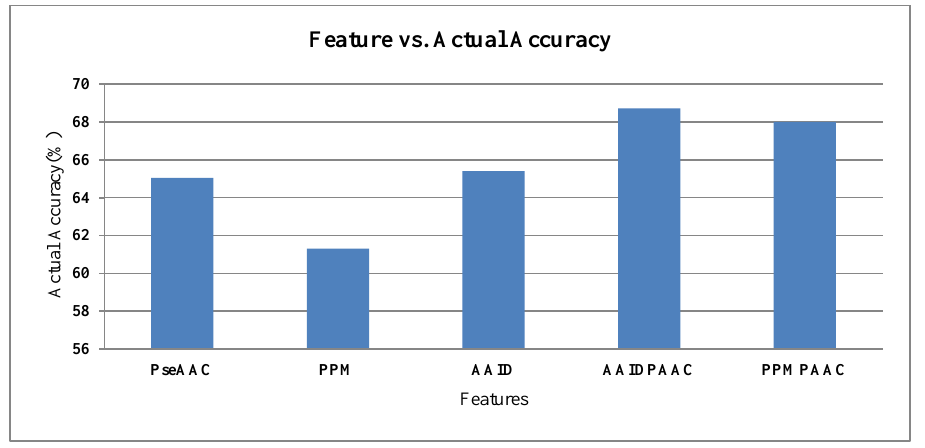
Figure 4: Actual Accuracy (%) for different Features